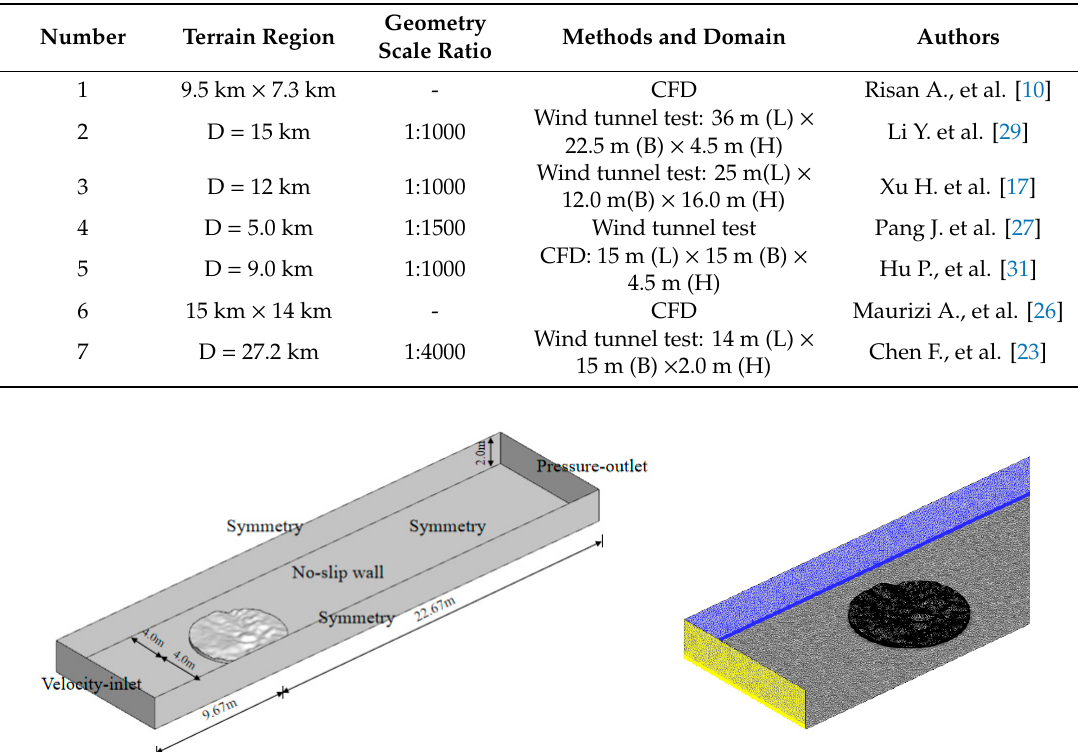
Table 2. Summary of main parameters of mountainous terrain models.